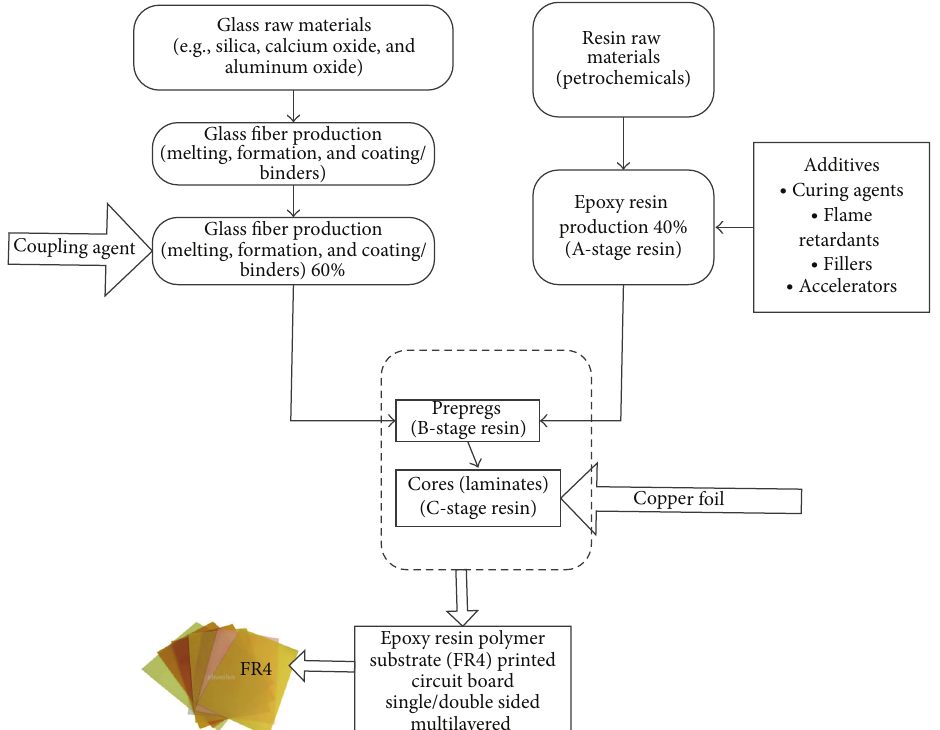
Figure 2: FR4 material construction.